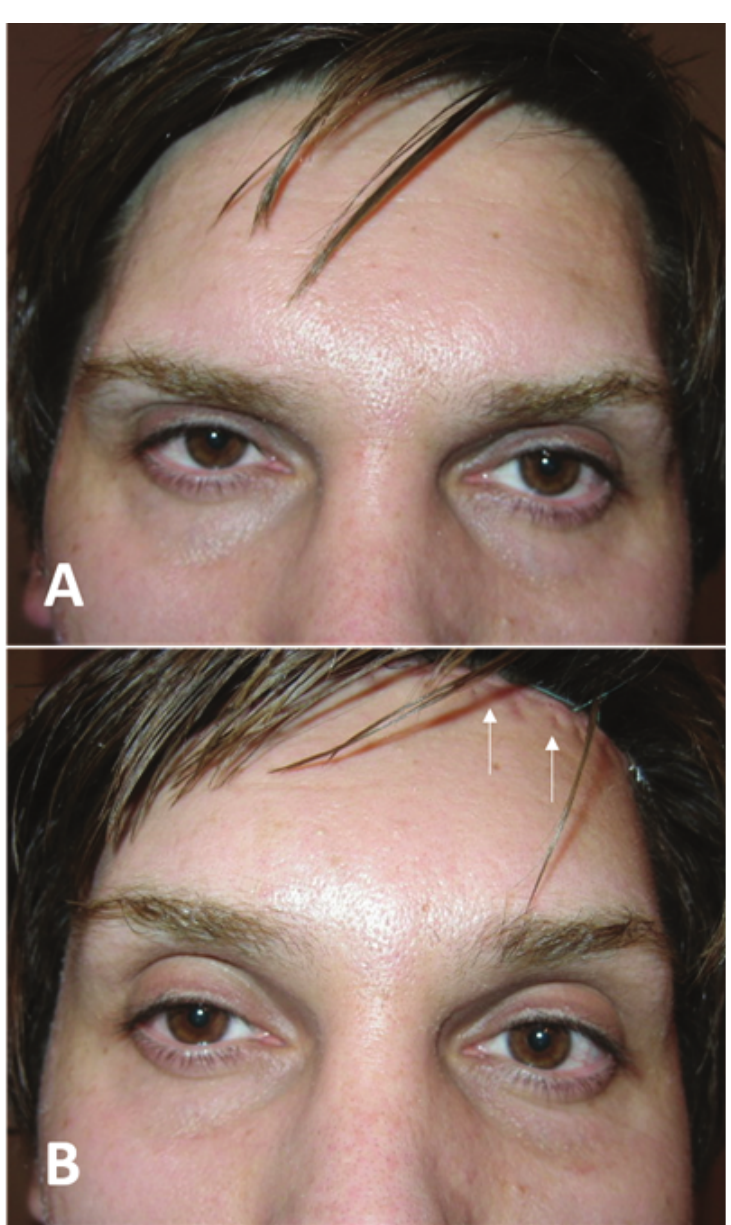
Figure 14. A young man with high hair line and total eyebrow ptosis (A) underwent pretrichial endoscopic forehead lift (B). While the lift effect is appreciated (B), scar of incision (arrows) will be visible for months and should be covered with hair